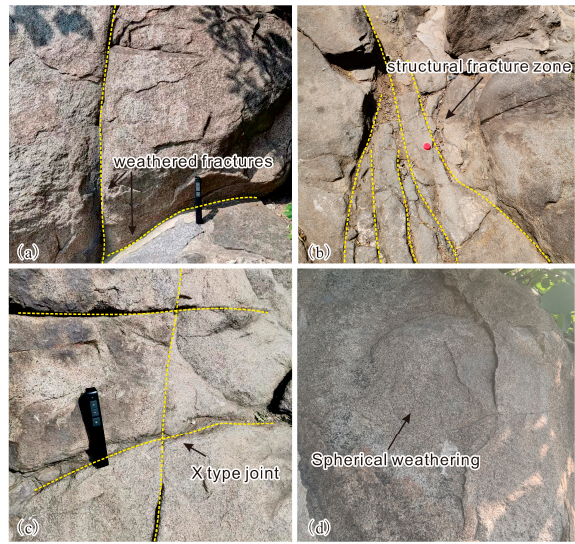
Figure 5. Fracture development and spherical weathering of the Ji’nan rock mass. ( a )—X type joint and weathered fractures; ( b )—Structural fracture zone; ( c )—X type joint and weathered fissures; ( d )—Spherical weathering.